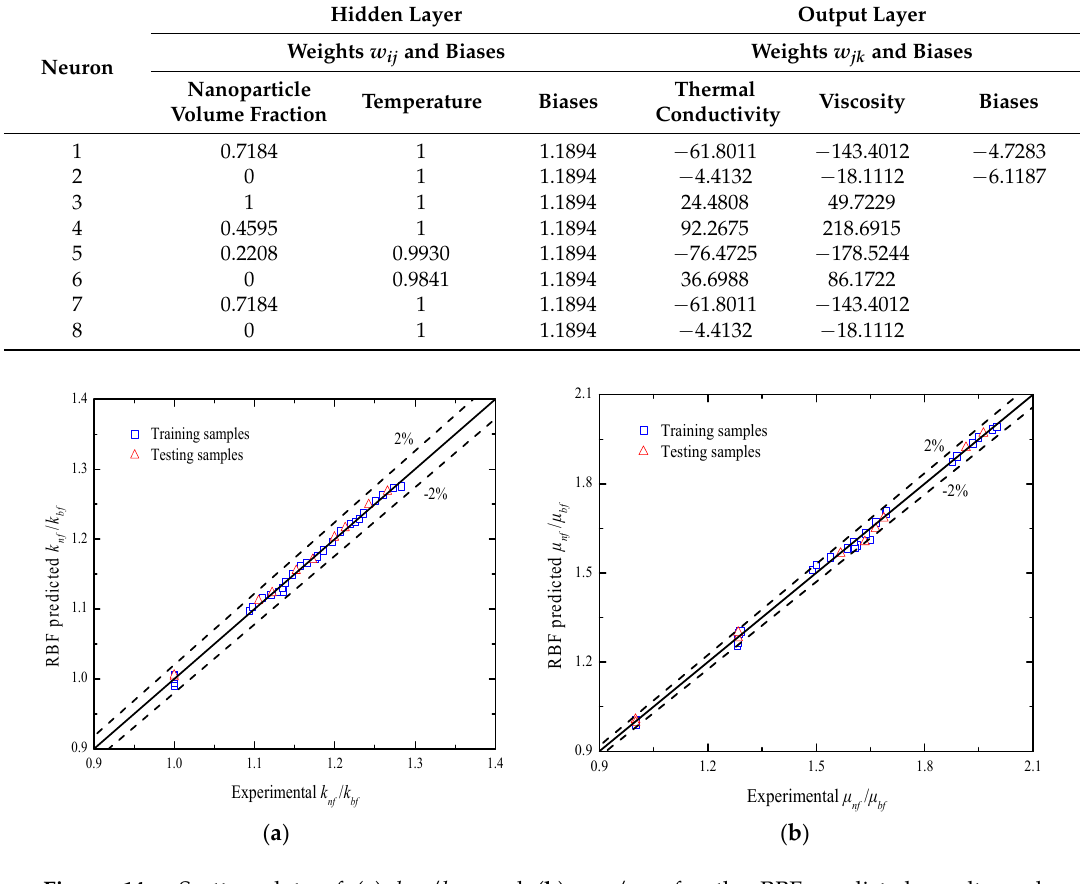
Figure 14. Scatter plots of ( a ) k nf / k bf and ( b ) µ nf / µ bf for the RBF predicted results and experimental data.